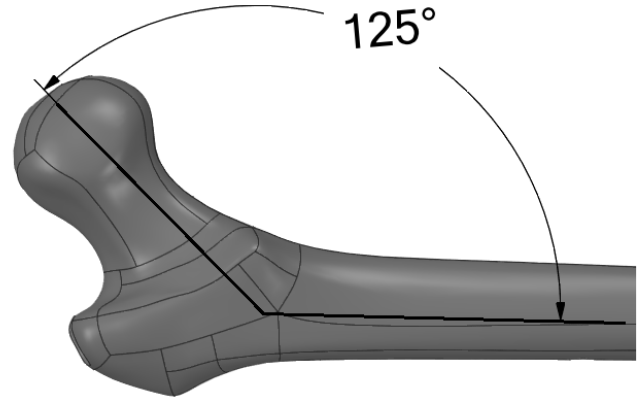
Figure 4. Collo ‐ diaphyseal angle of anatomical CAD femur.